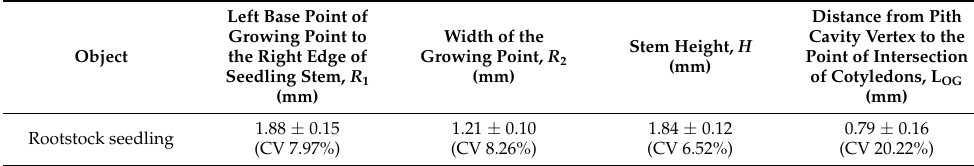
Table 2. Structural parameters of pith cavity of rootstock